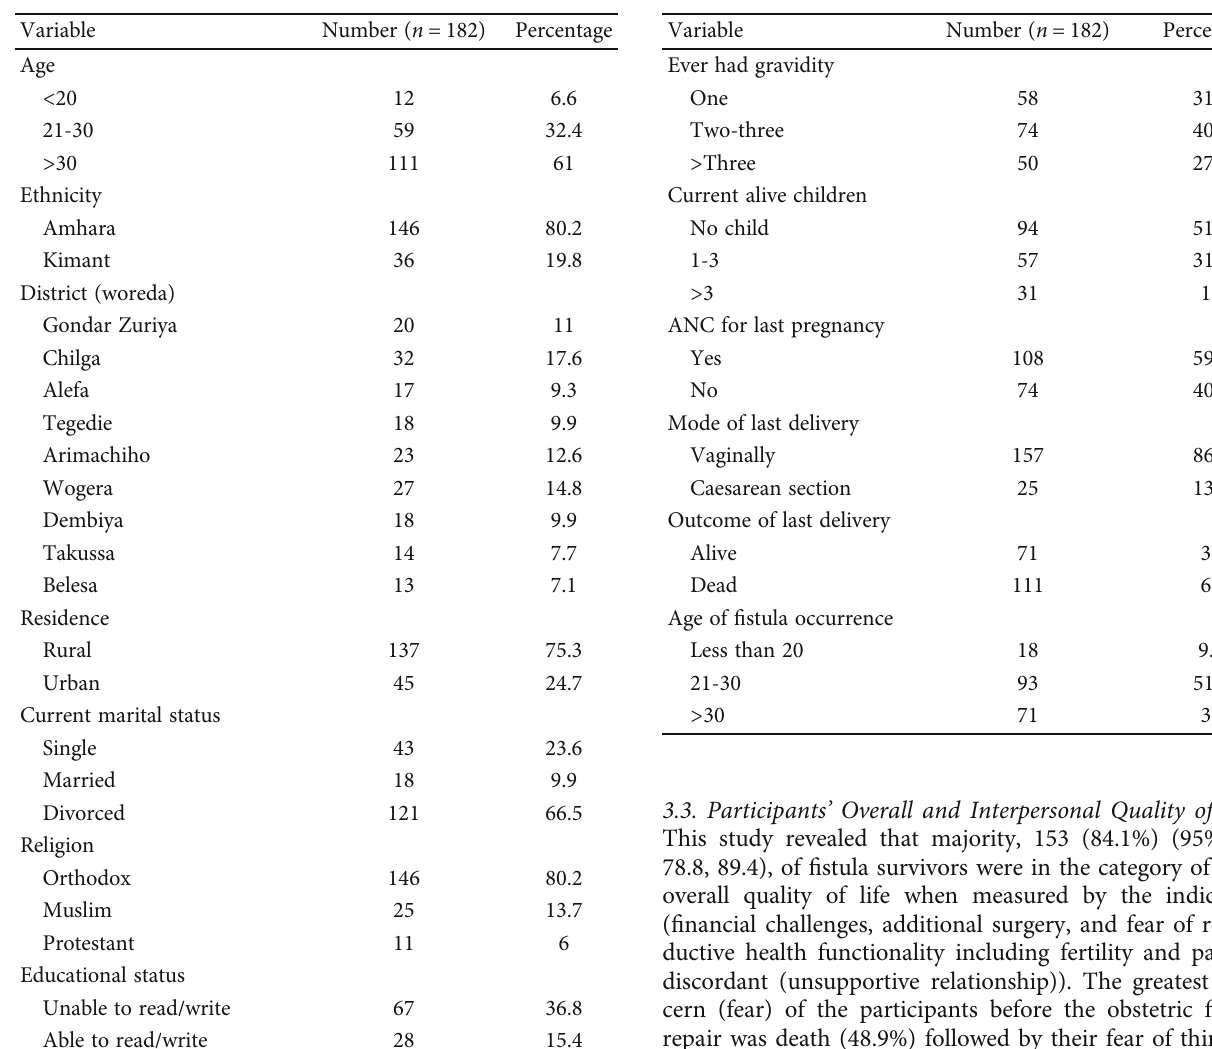
Table 1: Sociodemographic characteristics of the study participants Table 2: Obstetric history among fi stula survivors ( n = 182